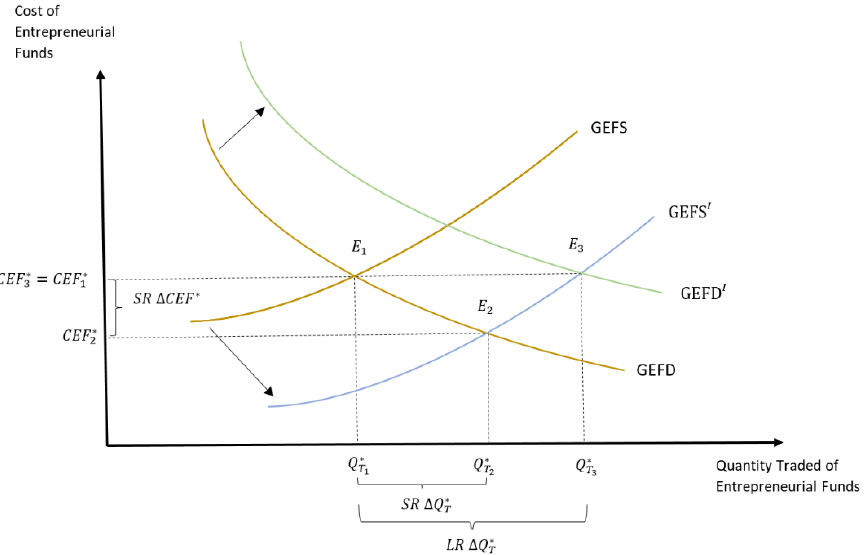
Figure 3. GEFM dynamics under public and private sectors financial injection, with exogenous financial intermediation.